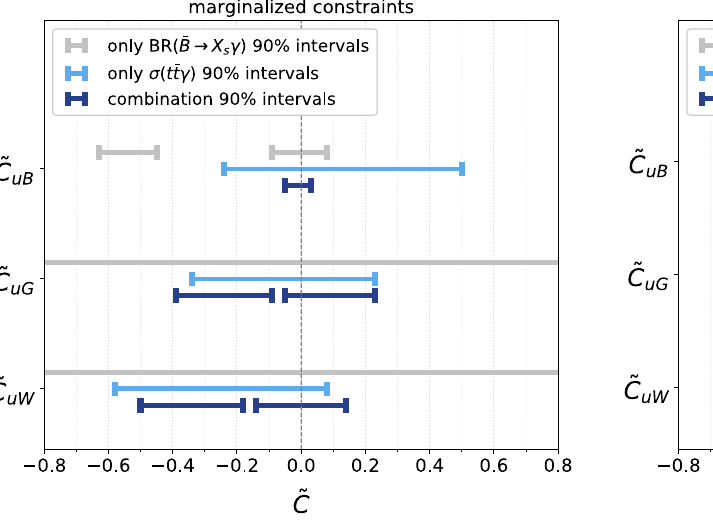
the fit of all three Wilson coefficients at a time and (right) for individual fits of each Wilson coefficient, while the other two coefficients are fixed to